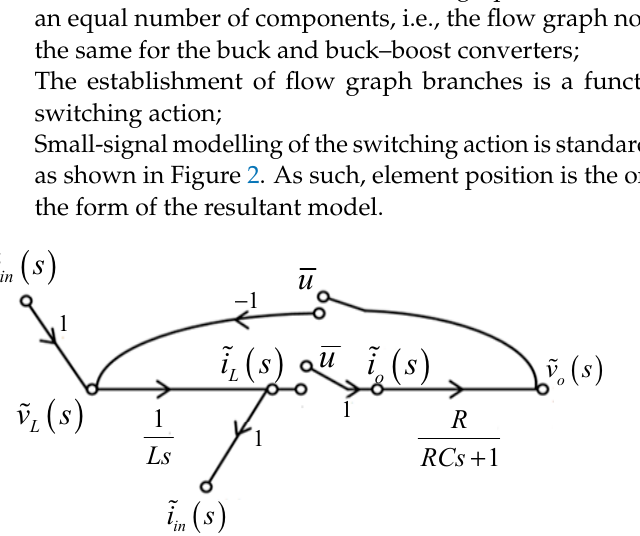
Figure 2. Small-signal switching flow graph for the switch ( a ), and the diode ( b ). 2.1. Identifying Influential Element and Its Variants Taking note of the influence that the switching elements display throughout all the major modelling techniques, (i.e., state-space, circuit averaging or SFG), it is then more convincing to identify the two switches as the elements with the most influence on the resultant model since they constitute the entire non-linearity of any switching converter [47]. There are two main variants of switching elements for the group of converters con- sidered in this study, i.e., single-pole double-throw (SPDT), commonly known as the PWM switch [47], or single-pole single-throw (SPST), which is a model for any discrete switch. For all converters in groups A and C–F of [26], the operation of the switching ma- trix, which is comprised of the active switch and the passive switch, can be fully described by an SPDT switch. This feature is seen in 24 converters out of a total of 30 converters considered in the study. The switching matrix for converters in group G of [26] cannot be fully described by an SPDT switch, since it mainly consists of two separate SPST switches. A direct application of the rules developed for the SPDT group on converters in group G results in incorrect models when compared with the corresponding models developed using existing modelling techniques. This observation comes as no surprise, due to the study by M. Veerachary [33] where a generalized large-signal flow graph model of the most popular fourth-order converters is presented. The converters from group G showed unique traits which were subsequently added to the proposed common SFG. As such, the set of rules developed for converters in group G (SPST group), will be different from those developed for converters in groups A and C–F in the proposed modelling procedure. 2.2. Introducing Model’s Standard Form To avoid unnecessary confusion, a standardized form of the resultant dynamic model is established, i.e., all derived converters’ models are computed in established standard form. Most transfer functions of interest for any system are often represented as a ratio of two polynomials. As such, the standard form opted for, in this paper, is shown in (1). Its choice was mainly influenced by the fact that some of the coefficients in the model retain the